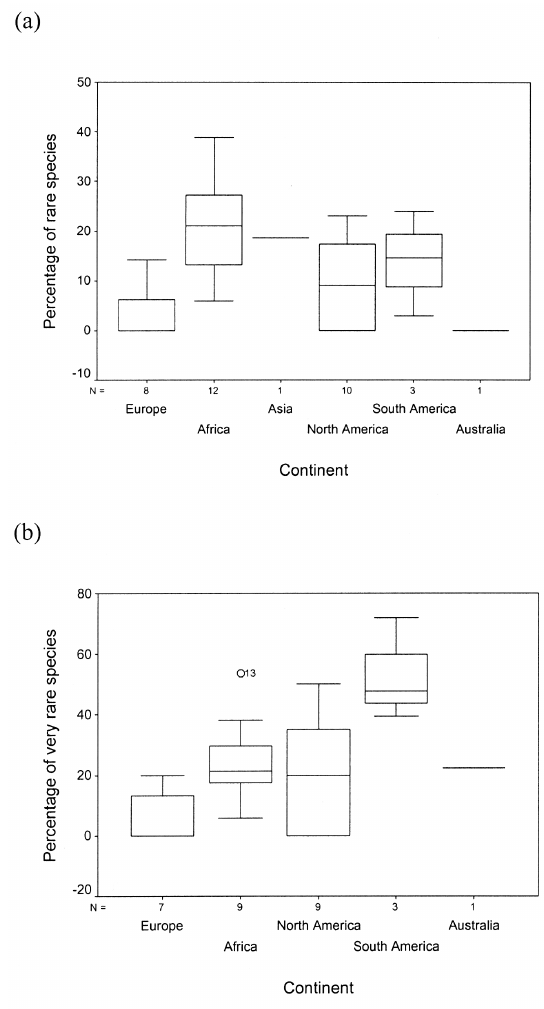
Fig. 2. Intercontinental variation in the percentage of rare species (graphic a) and of very rare species (graphic b) in snake commu- nities throughout the world. Box and whiskers show mean, standard deviation and standard error. The outlier in graphic b (13), is a Senegal savannah locality (Appendix 1 for more details). N = number of